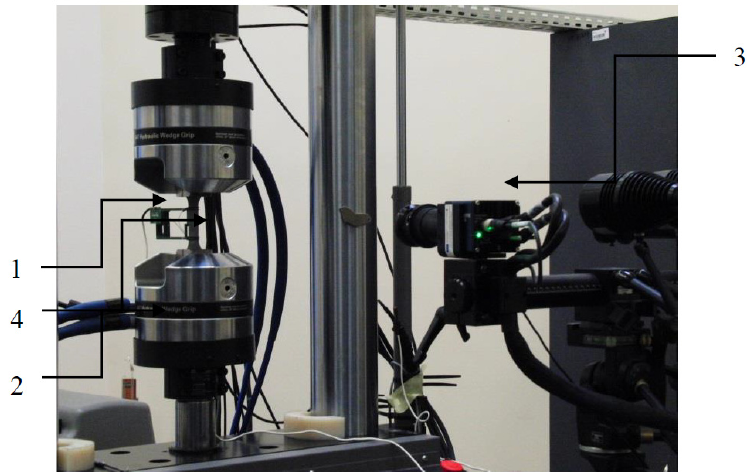
Figure 4. Experimental setup and the sample [5].